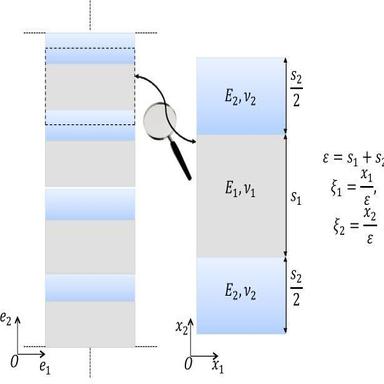
Heterogeneous bidimensional domain with its layered periodic cell.